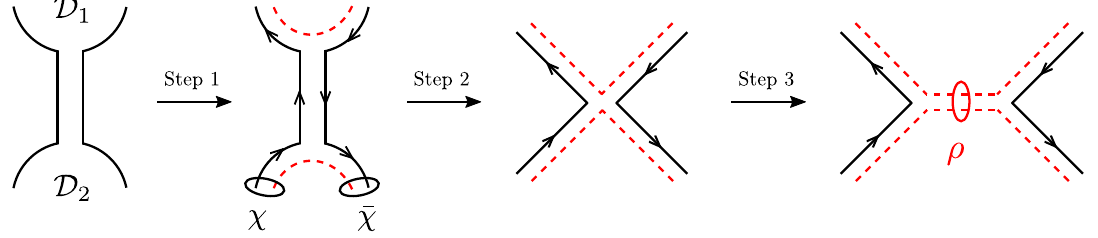
Figure 9 . Graphical interpretation of the rewriting procedure. The fermion (cid:12)elds (cid:31) and (cid:22) (cid:31) corre- spond to a double line made up of a dashed line and a black line. As a result of integrating in and out, we resolve the quartic interaction and introduce a double line made up of two dashed lines. This corresponds to the (cid:26) (cid:12)eld that we obtained in the